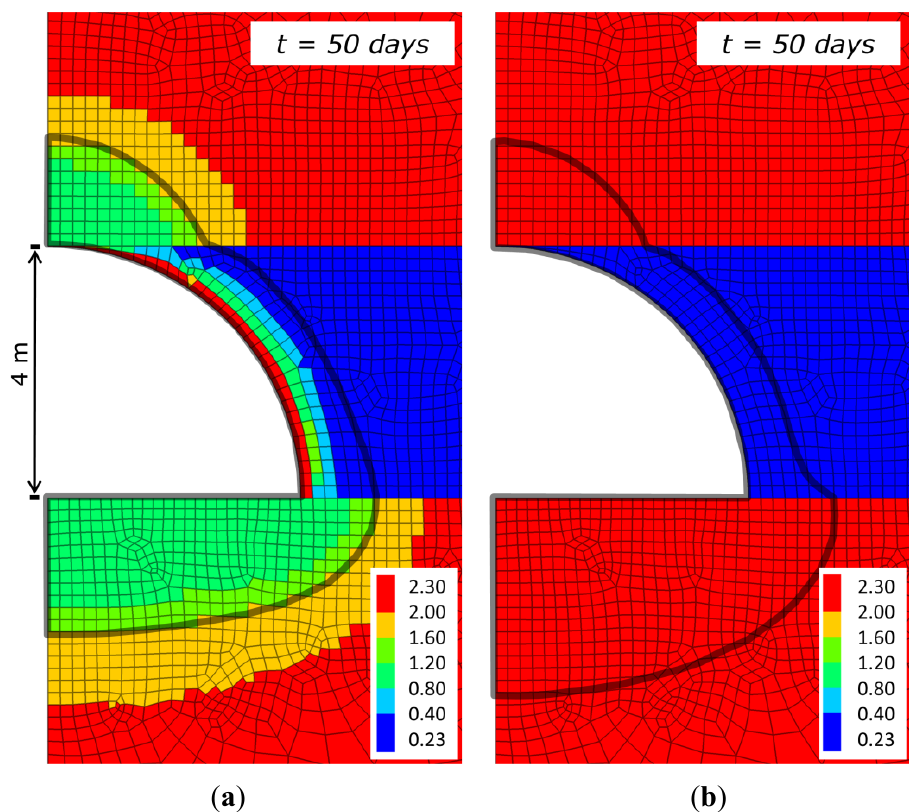
Figure 7. Distribution of the thermal property thermal conductivity (W/m/K) after 50 days of simulation with ( a ) temperature-dependent and ( b ) temperature-independent properties (initial values). The grey solid line represents the 200 °C